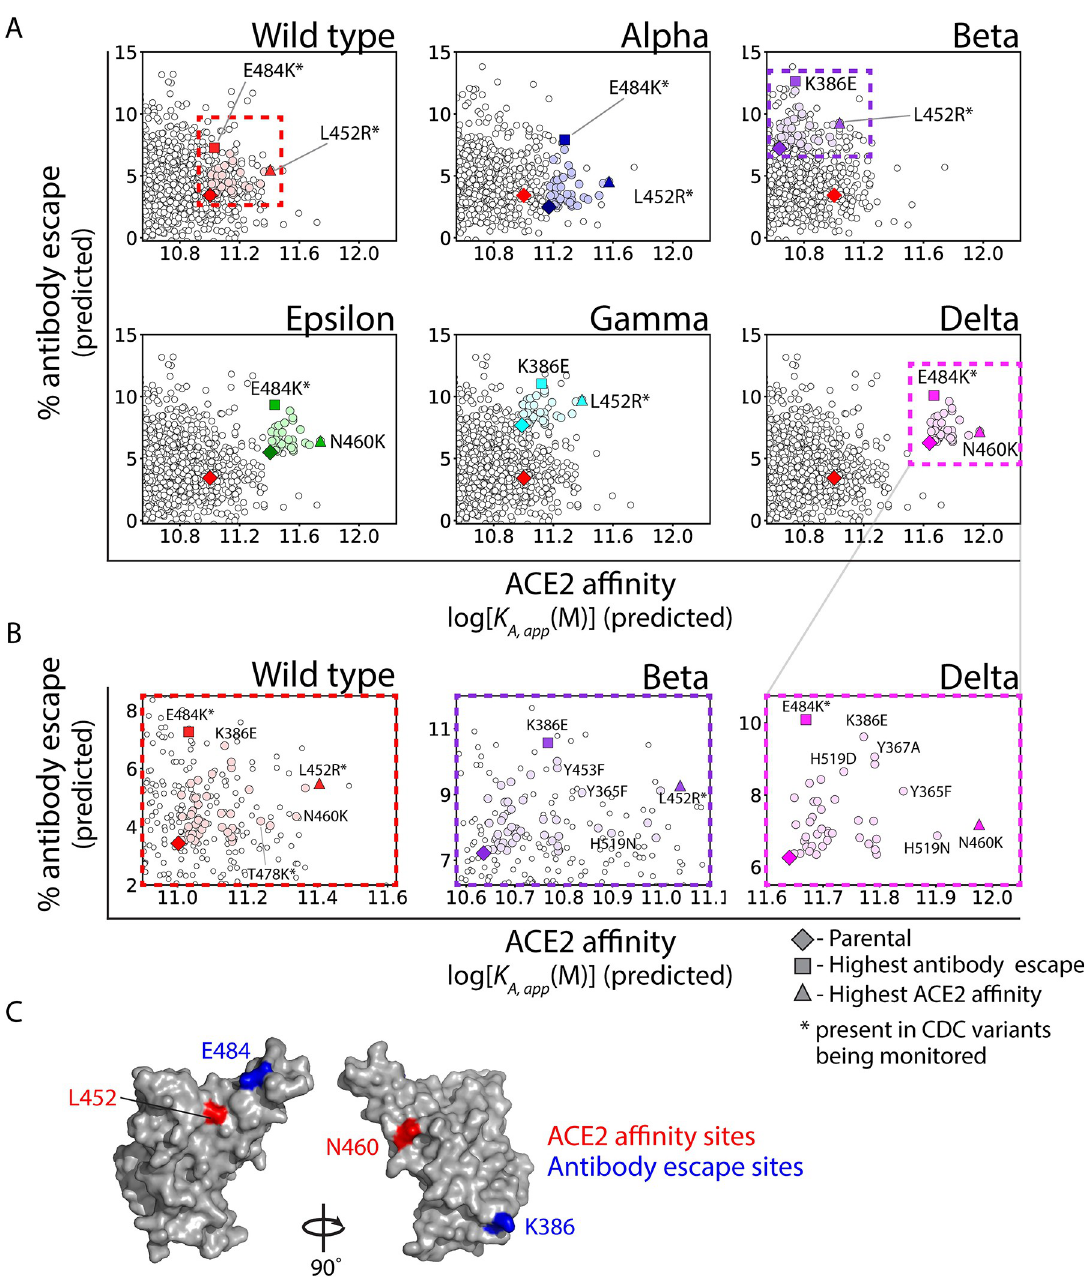
Fig 4. Predictions of single mutations in wild-type SARS-CoV-2 and additional single mutations in current and former CDC Variants of Concern at the Pareto frontier with the largest increases in ACE2 affinity or antibody escape. (A) Single RBD mutations that are predicted to increase ACE2 affinity or antibody escape without reducing the other property for wild-type SARS-CoV-2 and Variants of Concern. (B) Expanded view of the graphs in (A) with highlighted single RBD mutations that increase ACE2 affinity or antibody escape. (C) Location of key RBD sites that are commonly mutated to increase ACE2 affinity (L452 and N460) and antibody escape (K386 and E484). In (A) and (B), colored symbols generally correspond to single nucleotide exchange mutations (except for wild- type SARS-CoV-2 or the parental Variants of Concern), while white symbols correspond to multiple nucleotide